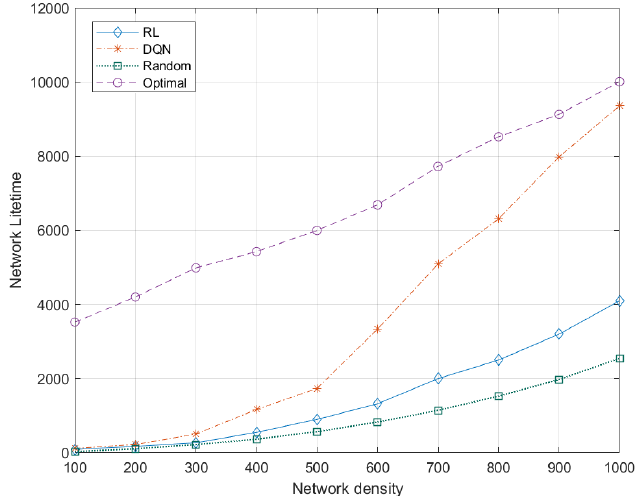
Figure 11. Network lifetime increases with respect to network density. DQN achieves higher values as compared to RL and random approaches. Higher network lifetime improves QoS and network